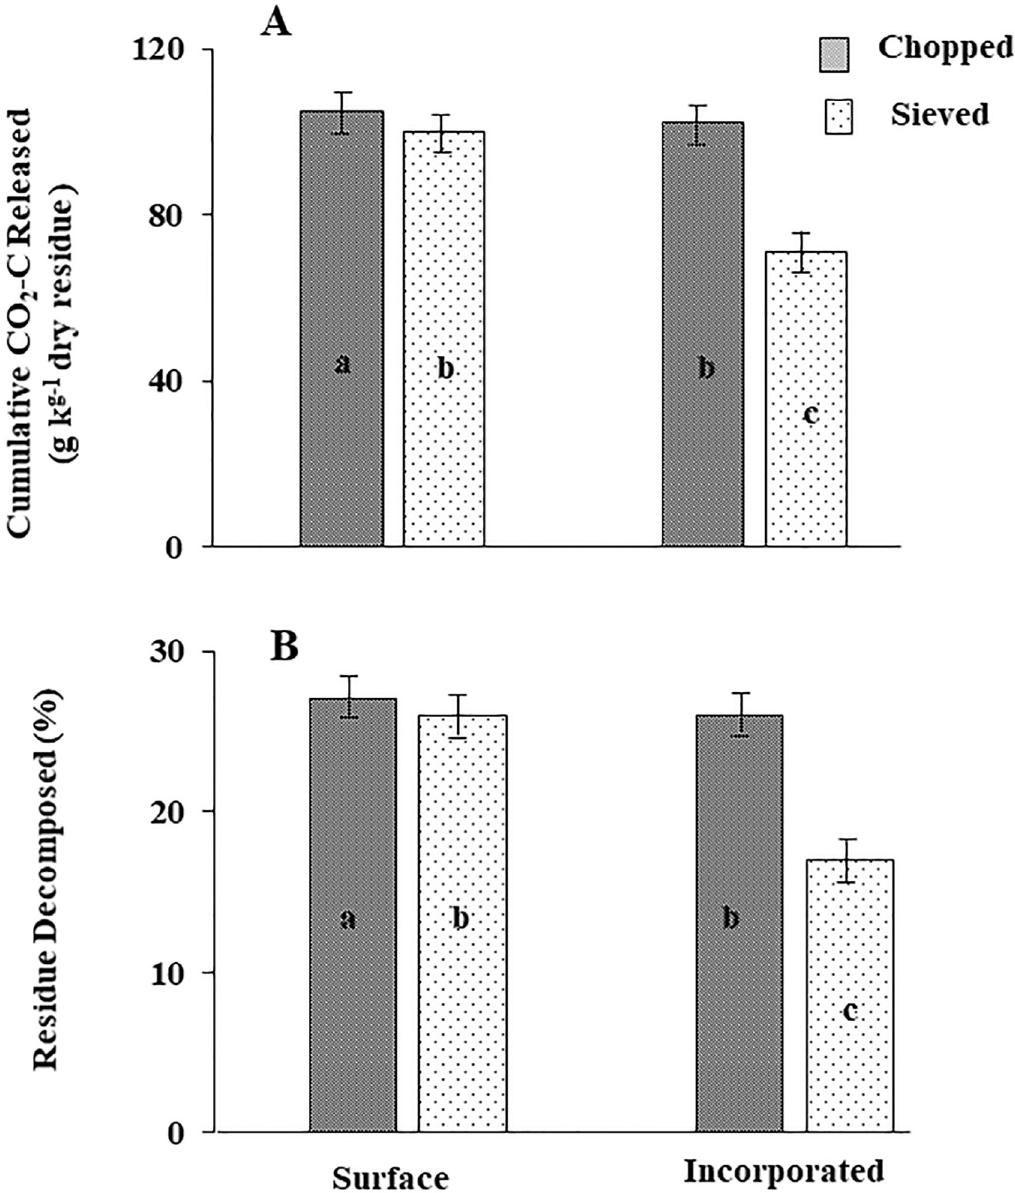
Fig 3. Effects of residue placement and residue size on A) cumulative CO 2 -C released (rate as calculated per kg of residues) and B) percentage of residue decomposed for barley residue decomposition averaged over two soils types in 50-days’ laboratory incubation study at 25